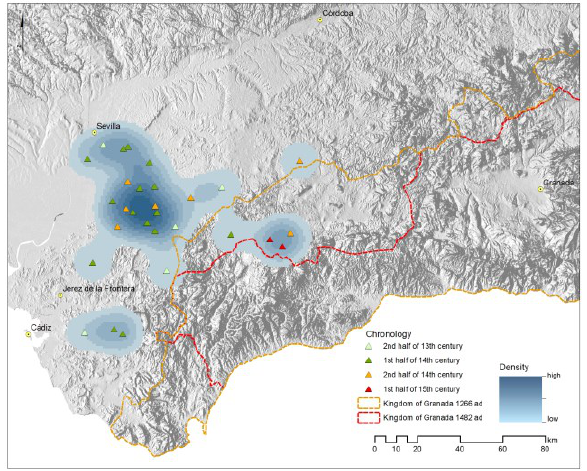
Figure 4: Thematic map showing the chronology of the towers and their location density.